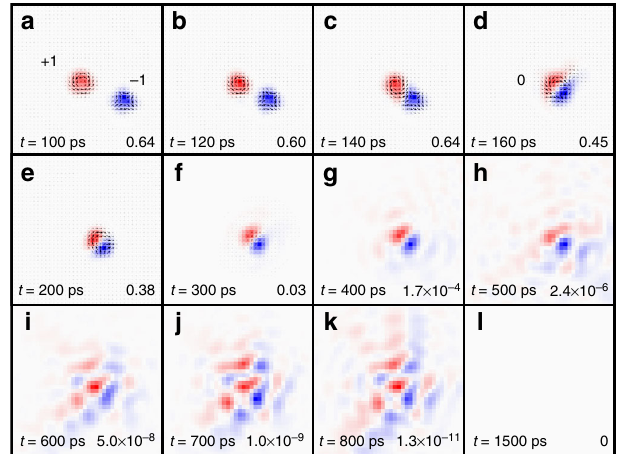
Fig. 10 Pair annihilation of a skyrmion and an antiskyrmion. a We fi rst place a skyrmion and an antiskyrmion. d They are spontaneously combined into a magnetic bubble ( Q = 0). Then, by emitting spin waves, it disappears. The spin wave can be discerned from g – k . The positive and negative skyrmion number densities are denoted by red and blue colors, respectively. Q is indicated in a and d . The maximum value of the Q density is indicated in the lower right corner of each snapshot. The model is a square element (60 × 60 spins) with the OBC. The parameters are J 2 = − 0.8, J 3 = − 1.2, K = 0.1, H z